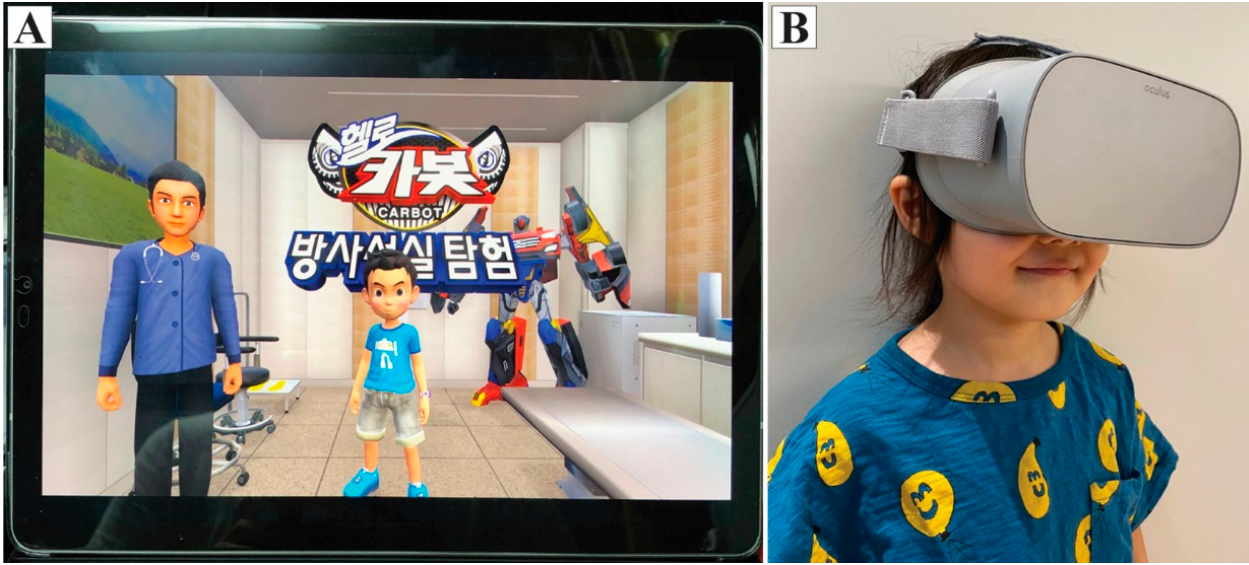
Figure 1. Experiential education platforms. ( A ) Tablet video. ( B ) Virtual reality experience with a head-mounted display.